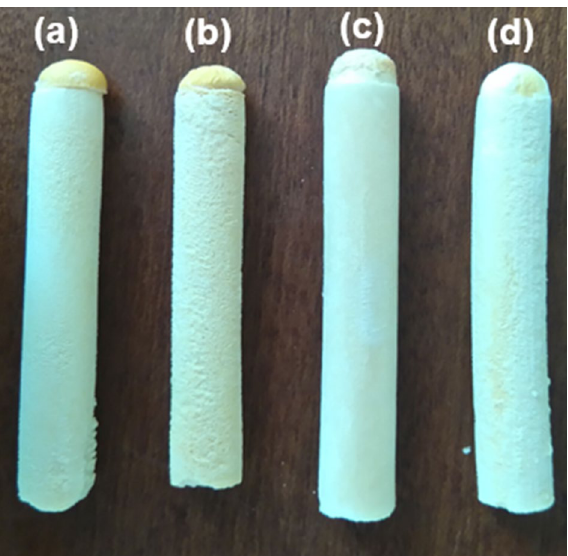
Figure 1. Photographs showing the physical form of ( a ) chitosan-alone; ( b ) chitosan/mPEG; ( c ) chitosan/ mPEG-CHO; and ( d ) chitosan/mPEG-COOH